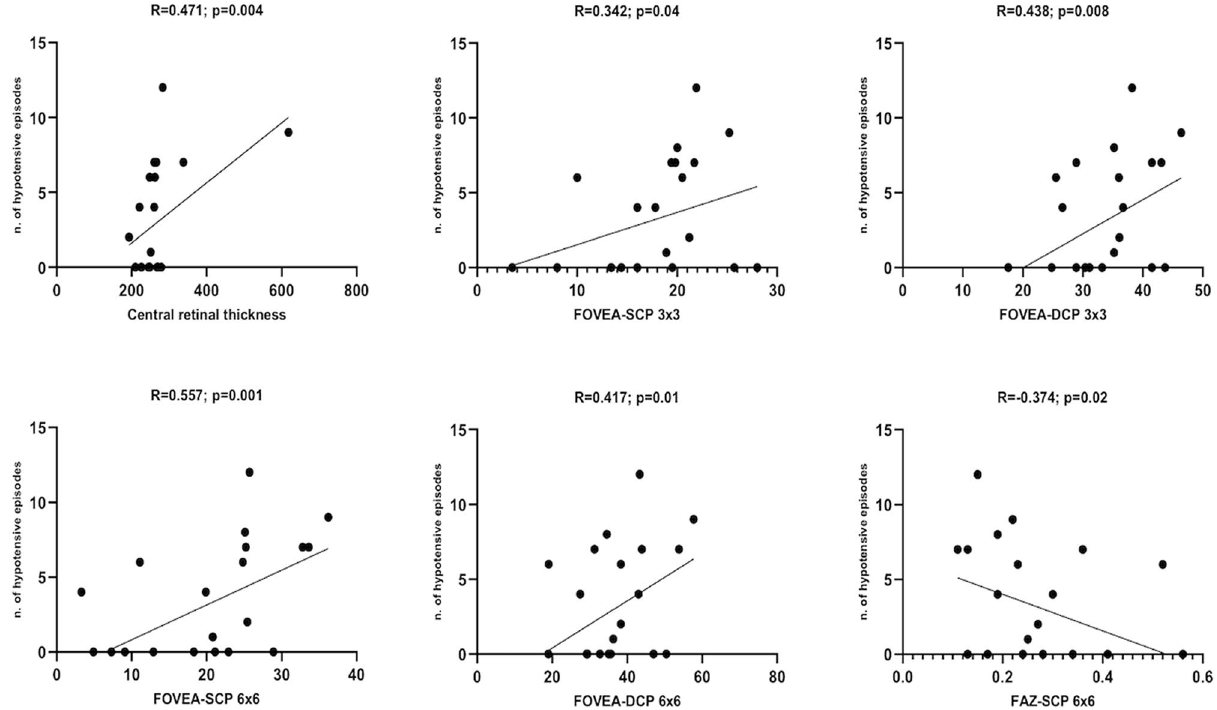
Figure 3. Correlations between number of hypotensive episodes and OCT-A parameters.